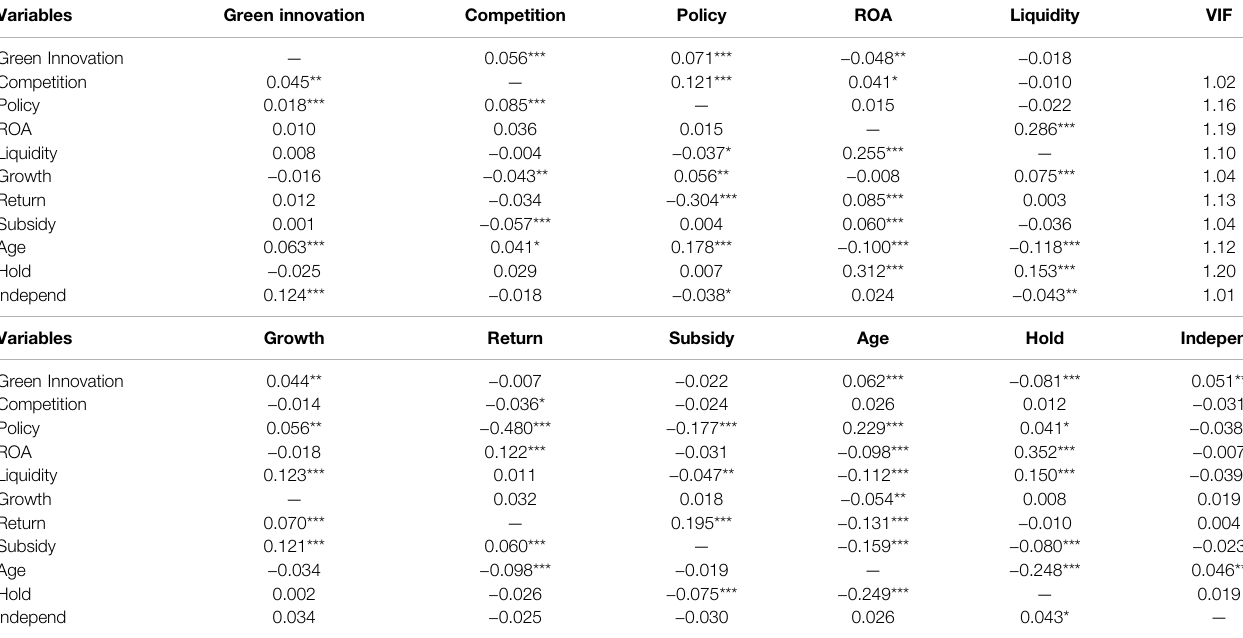
TABLE 3 | The results of correlation matrix.